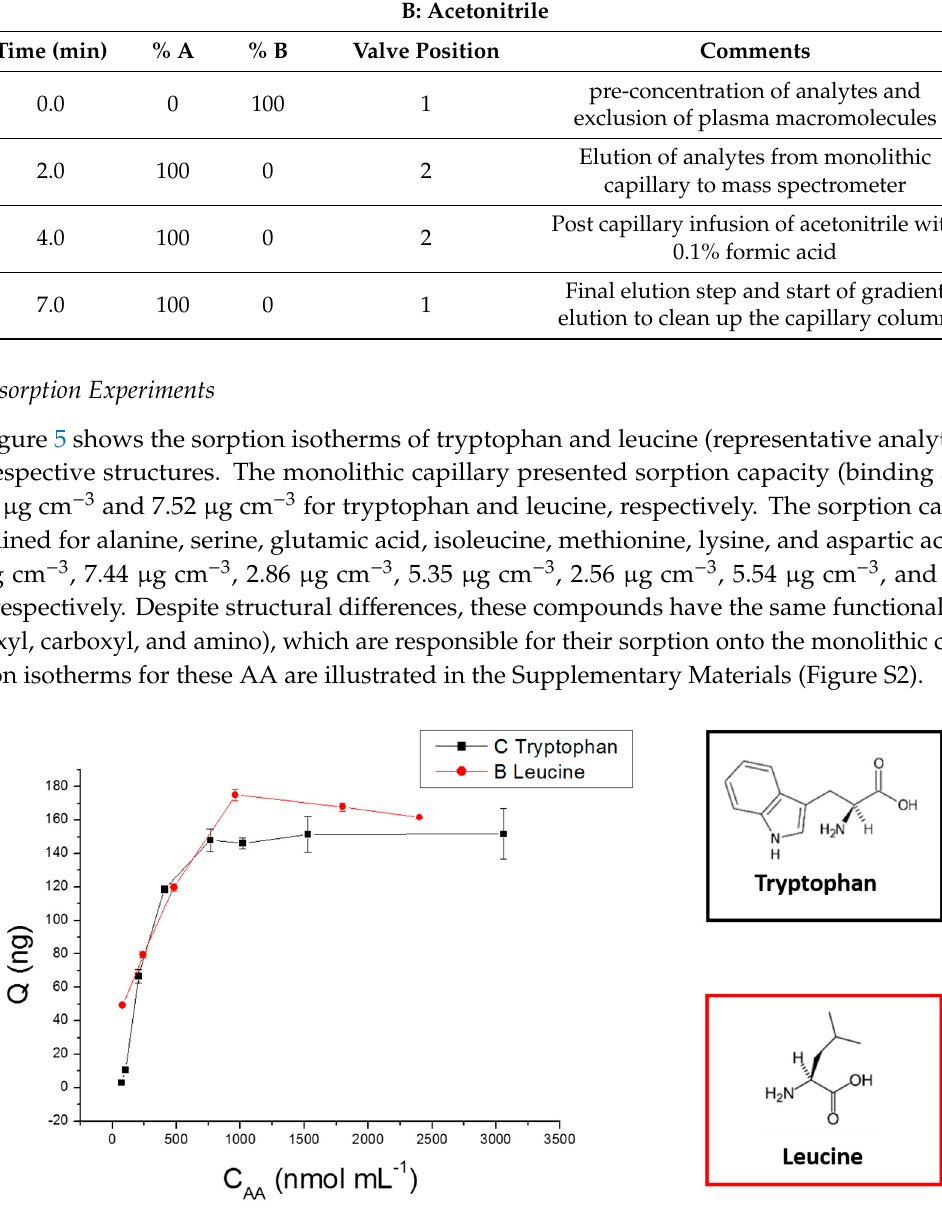
Figure 5. Sorption isotherm of the organic-inorganic hybrid silica-based monolithic capillary for tryptophan and leucine.